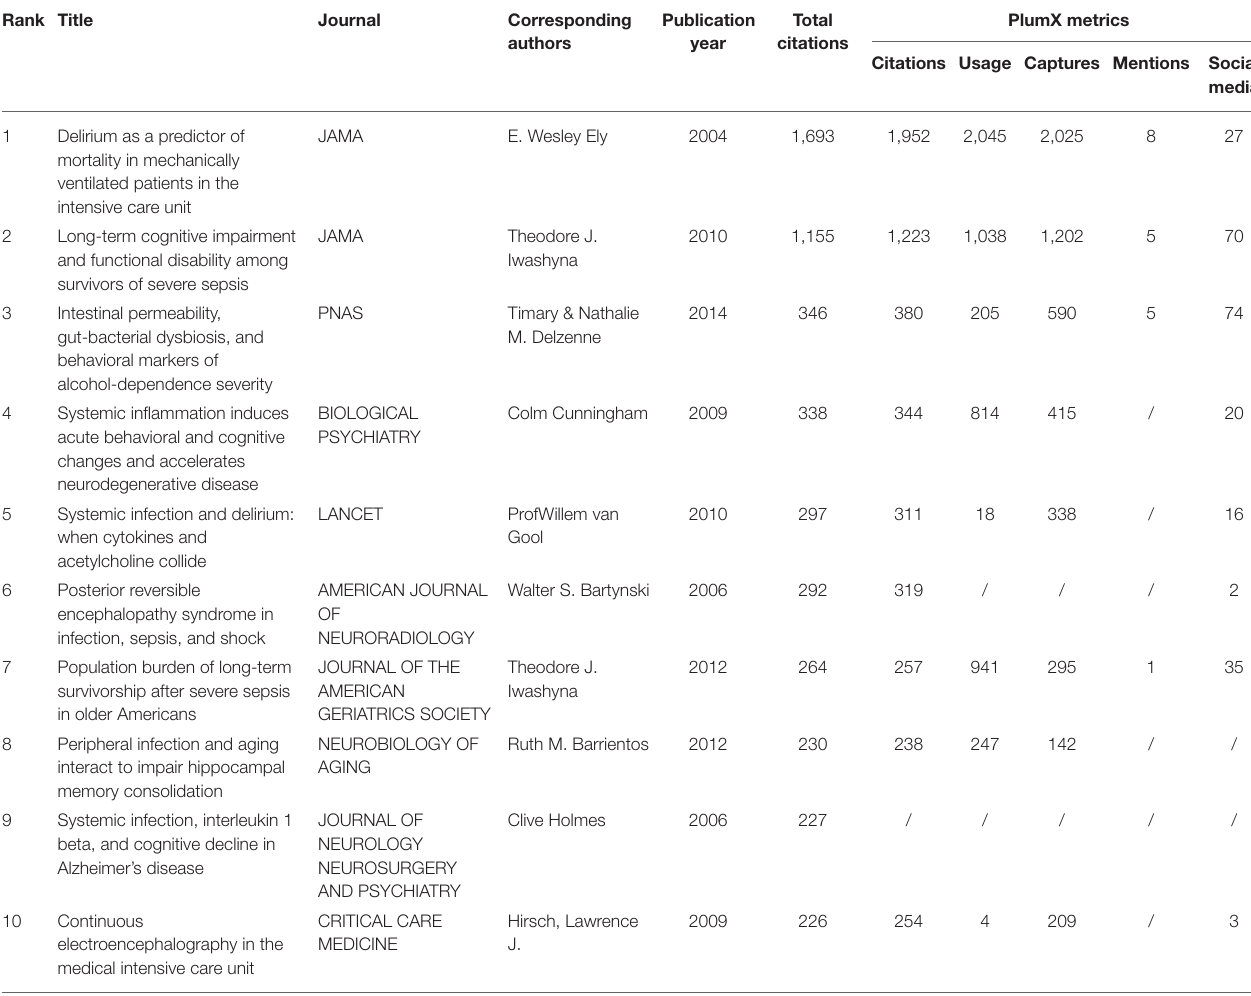
TABLE 1 | The top 10 high-cited papers in SAE research during 2001 to